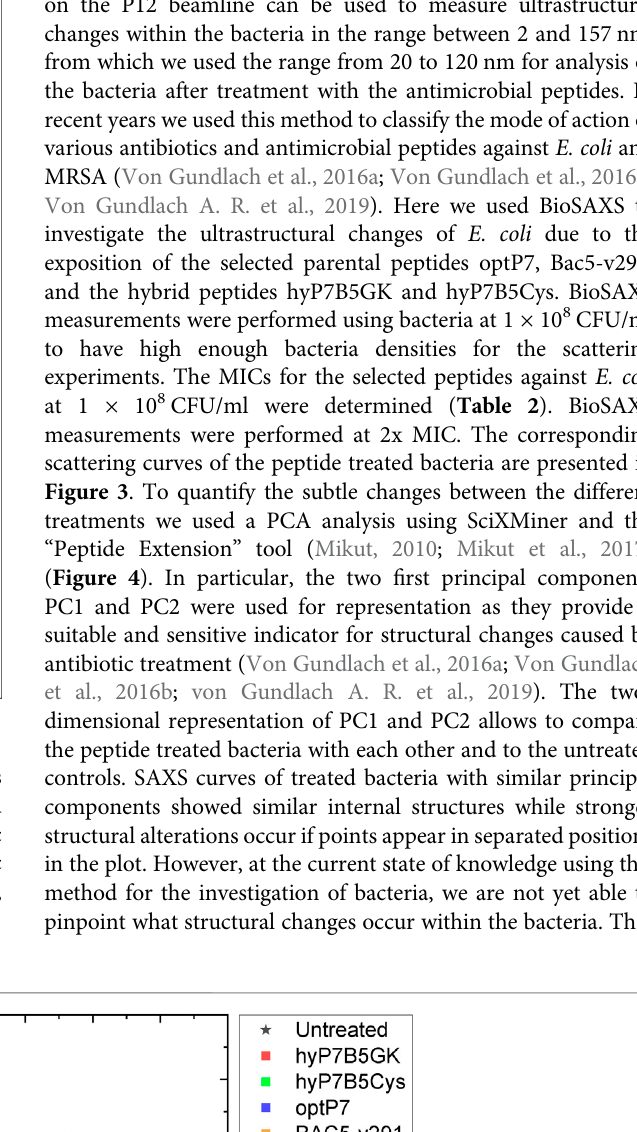
Frontiers in Pharmacology |